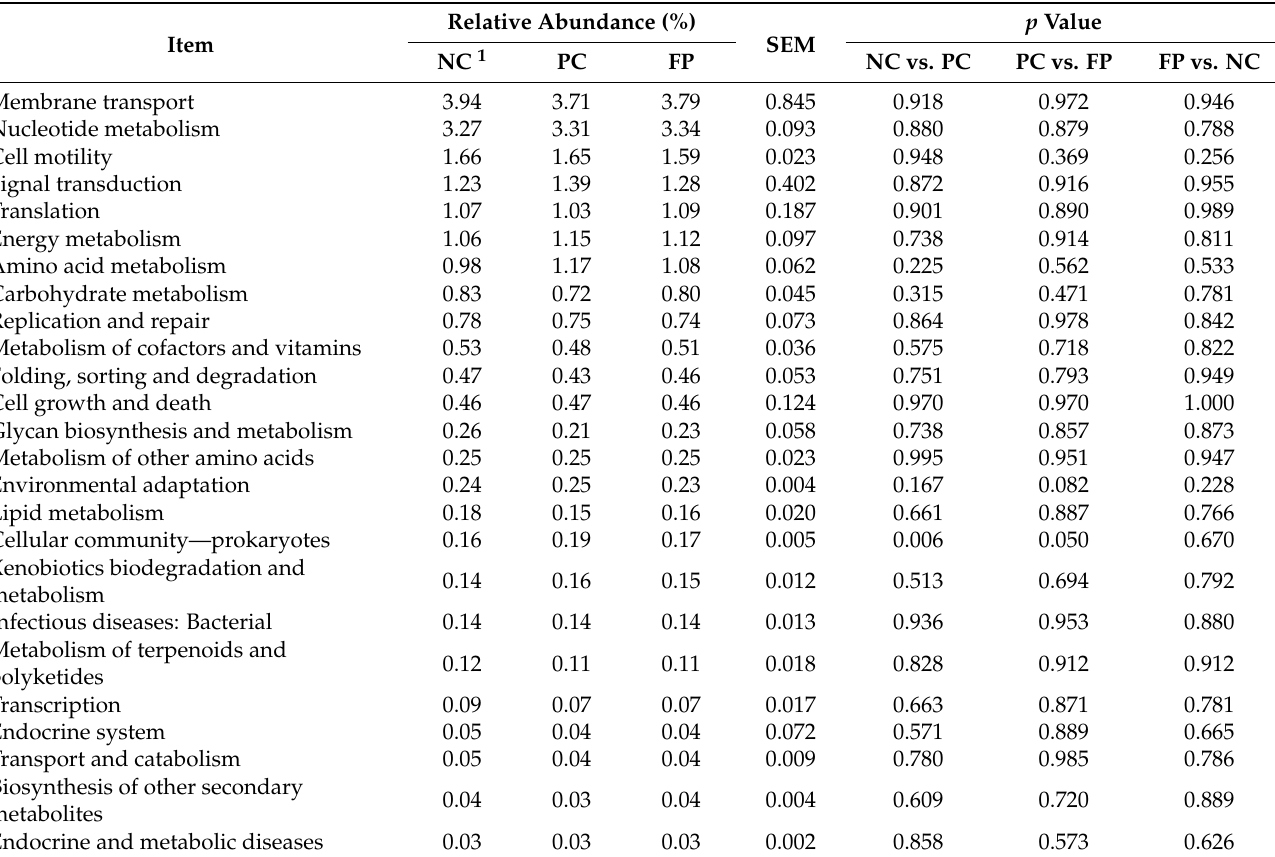
Table 6. Differences in microbial functions within the cecal digesta of broilers based on Kyoto Encyclopedia of Genes and Genomes functional